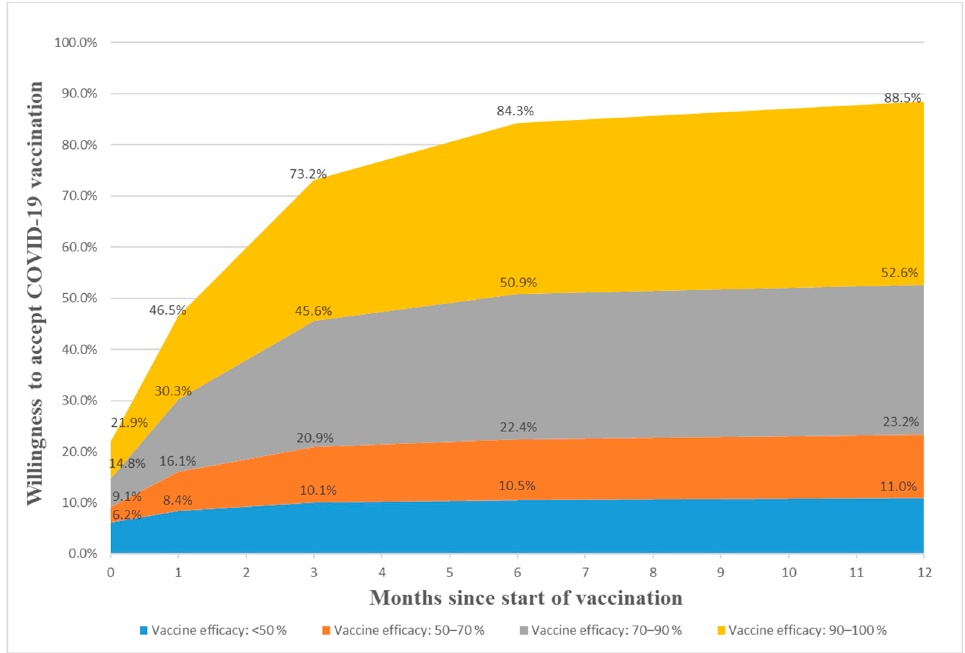
Figure 1. Possible ranges of acceptance of COVID-19 vaccination over time under different vaccine efficacy among respondents (n = 2013) in the well-contained phase (Nov–Dec 2020) in